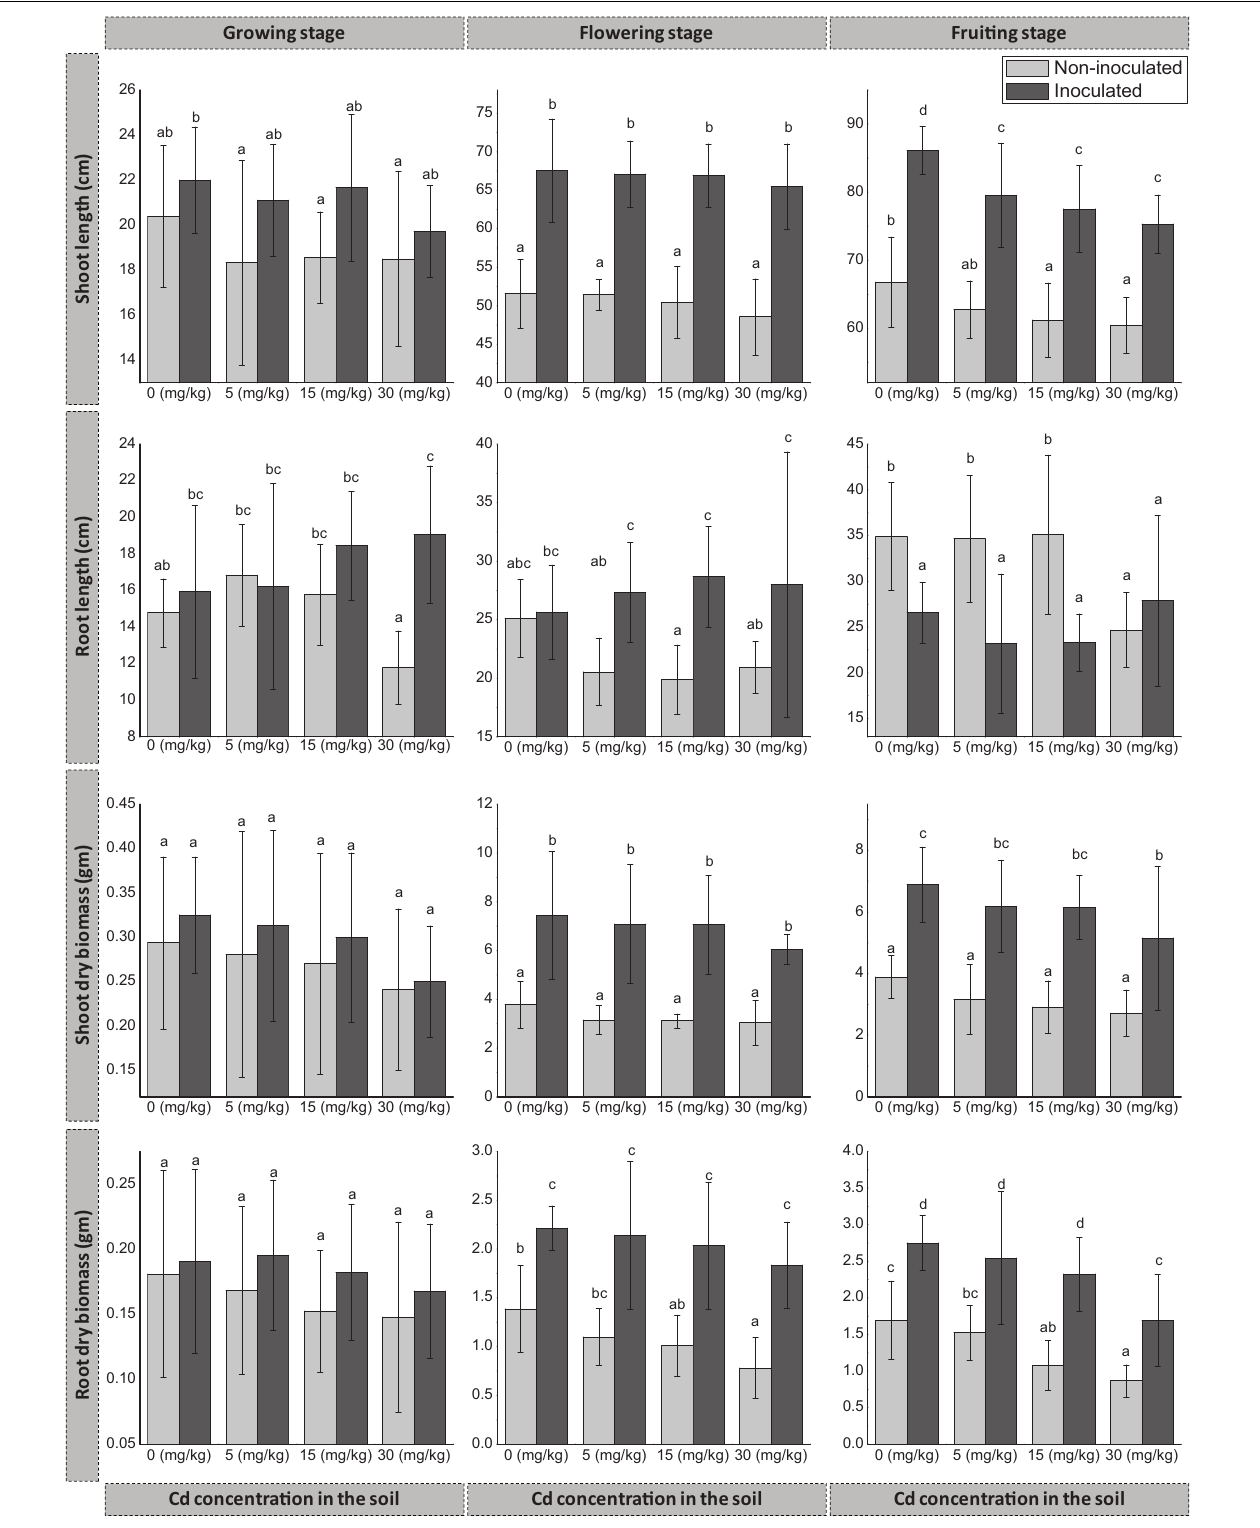
FIGURE 1 | Effect of seed endophyte FZT214 on D. ambrosioides growth under different Cd concentrations at different developmental stages (growing, flowering, and fruiting). The different lowercase letters indicate significant variation between treatments ( p < 0.05) according to Duncan’s test of one-way ANOVA. The shoot and root length, dry weight (mean ± STD, n =